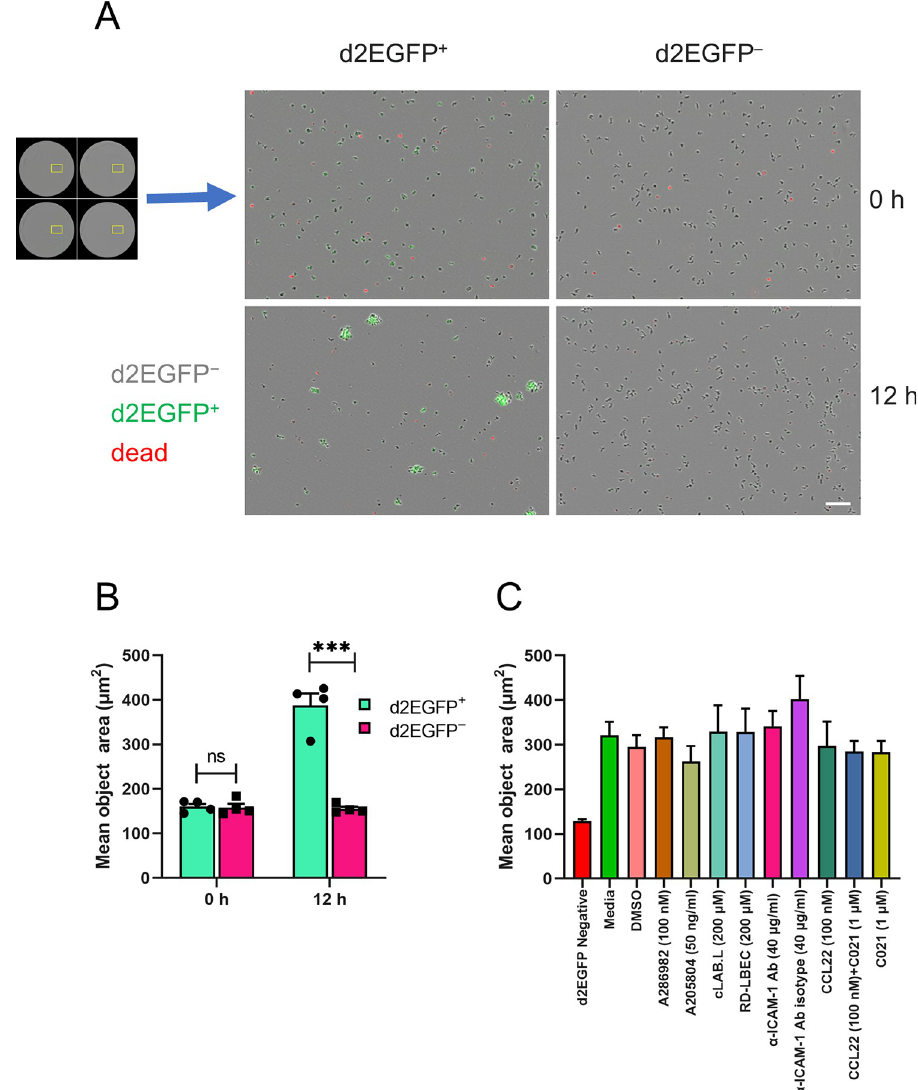
Fig 4. Tax-expressing cells form cell clumps. (A) Time-lapse live-cell imaging was performed on FACS-sorted d2EGFP + (Tax + ) and d2EGFP − (Tax − ) cells, acquiring whole-well images in phase (d2EGFP − cells), green (d2EGFP + cells) and red (YOYO-3 Iodide–dead cells) channels every 4 hours for 12 hours. The mean object area in wells seeded with d2EGFP + and d2EGFP − cells was quantified as outlined in Materials and methods. Representative images from clone d2EGFP TBX4B showing the cell clumps formed among sorted d2EGFP + cells at the end of the 12-hour culture. Scale bar– 100 μ m. (B). Mean object area of sorted d2EGFP + and d2EGFP − cultures at the beginning (0 h) and the end (12 h) of the culture. Data depict the mean and SEM from two independent experiments using clones d2EGFP TBX4B and d2EGFP TBW 11.50. (C) The effect of inhibition of LFA-1-ICAM-1 interaction or CCR4 expression on clump formation among Tax-expressing cells. FACS-sorted d2EGFP-positive cells from clone d2EGFP TBW 11.50 were pre- treated with agents for 1 hour at the indicated concentrations. FACS-sorted d2EGFP-negative cells were used as the negative control for clump formation. Whole-well time-lapse images were captured in phase contrast, green and red channels over 12 hours at 4-hour intervals. The mean object area at the end of the 12-hour imaging under each treatment condition is shown. The data depict the mean and SEM from two independent experiments. Data in panel B were analysed by an unpaired Student’s t-test. ��� P < 0.001, ns–not significant.